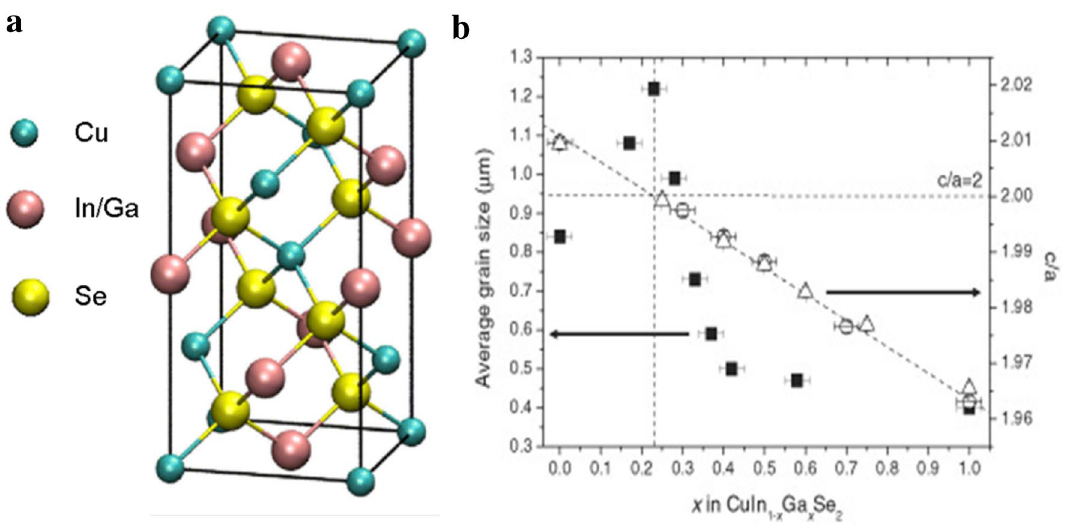
Fig. 1 a CIGSe crystal structure (adapted from Ghorbani et al. [13]. Copyright©2015, American Chemical Society, permission granted), b lat- tice constant ratio ( c / a ) deviation as a function of Ga content ( x ) [14] (Copyright© John Wiley and Sons, 2008, permission granted)